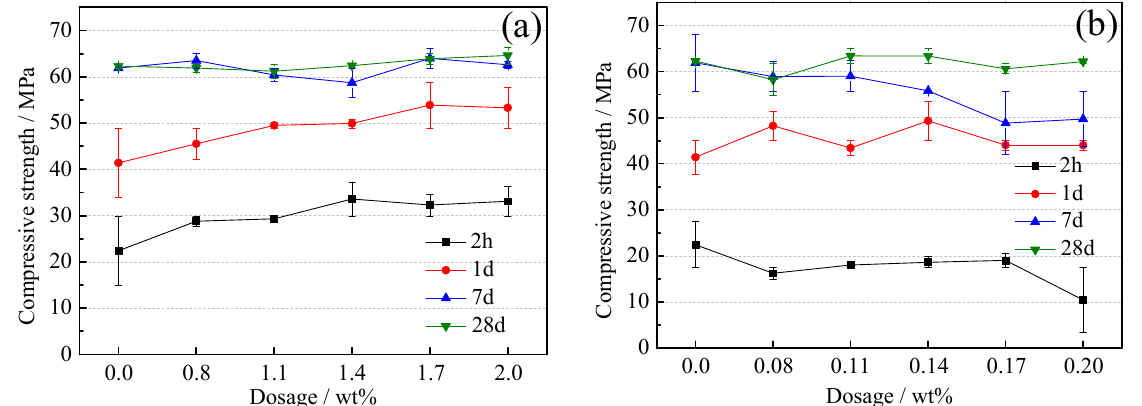
Figure 2. CSA mortars compressive strength with superplasticizers of ( a ) BNS, ( b ) PC.